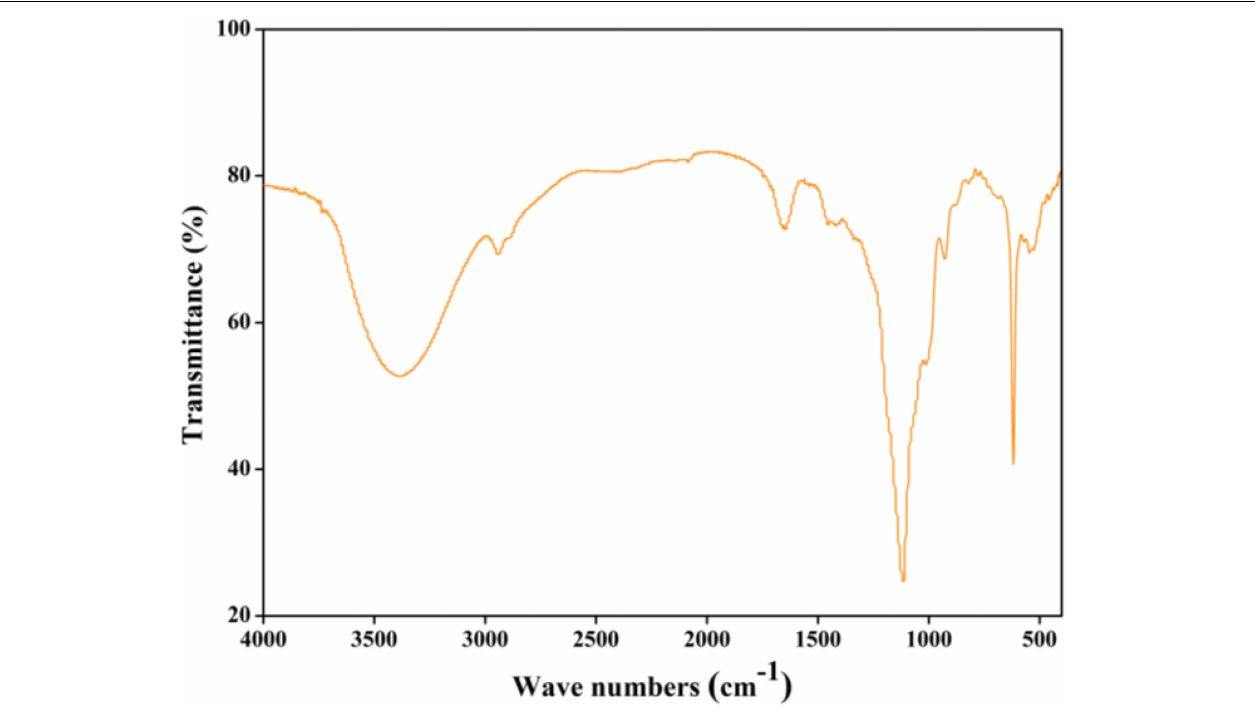
FIGURE 2 | Fourier-transform infrared (FT-IR) spectrum of